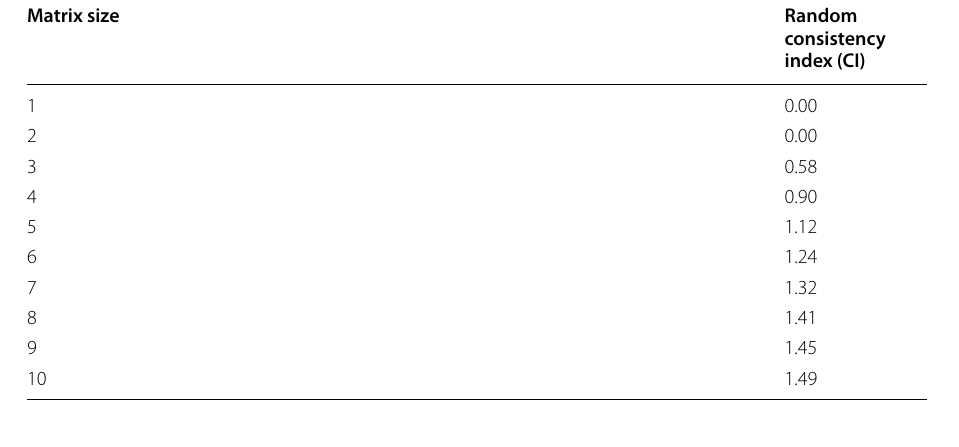
Table 2 CI table source (Saaty 1987)